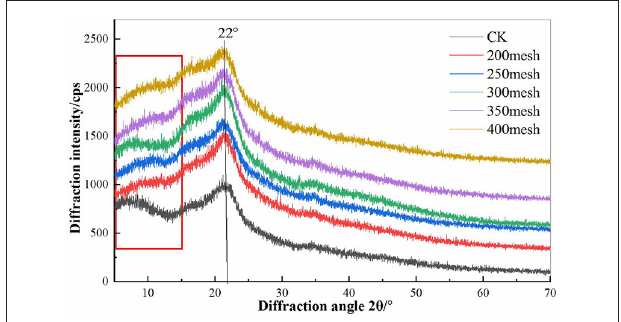
FIGURE 4 | The X-ray diffraction (XRD) of different particle size IDF from corn bran.